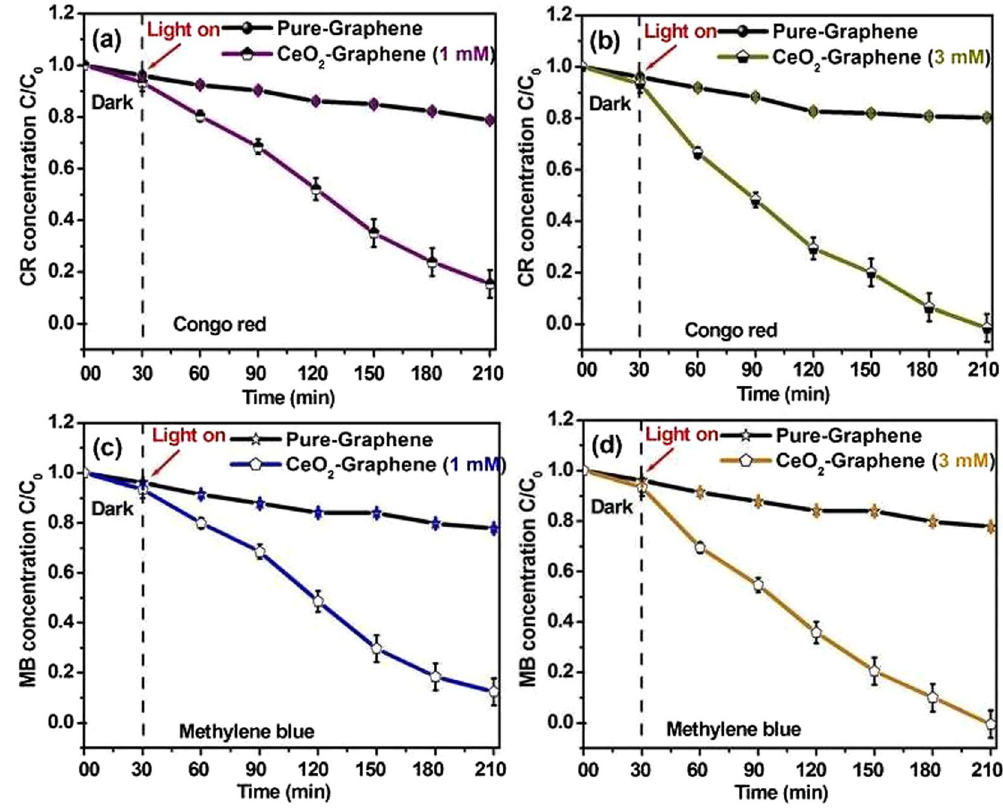
Figure 9. C/C 0 vs. time (h) plot for the photodegradation/decolorization of ( a and b ) CR, and, (b) MB ( c and d ) using pure-graphene, and 1 mM and 3 mM CeO 2 -Graphene nanostructures as photocatalyst in the dark and under visible light